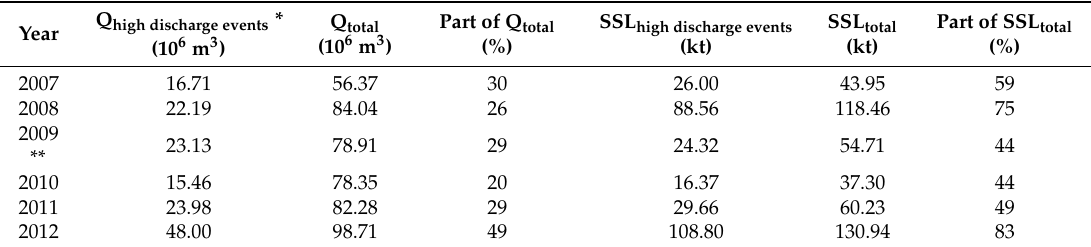
Table 3. Runoff (Q total ) and suspended sediment load (SSL) from Werenskioldbreen catchment, divided into the total amount and high discharge event